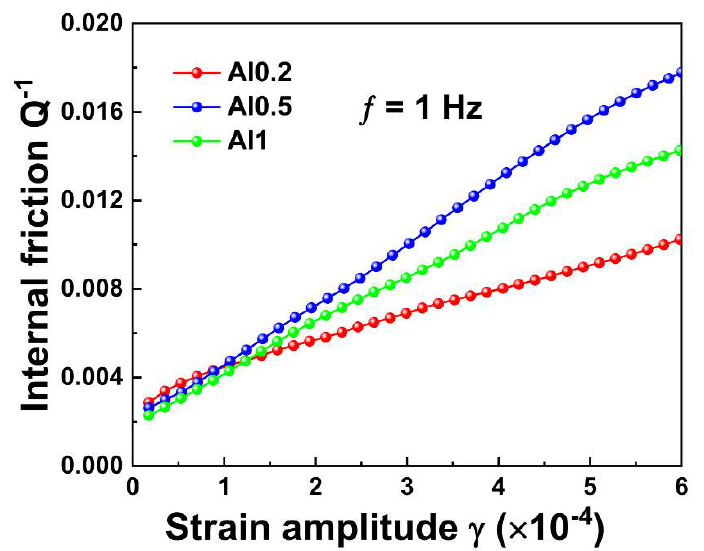
Figure 7. The damping-strain amplitude diagram of the AlxCoCrFeNi (x = 0.2, 0.5 and 1) HEAs at a test frequency of 1 Hz.